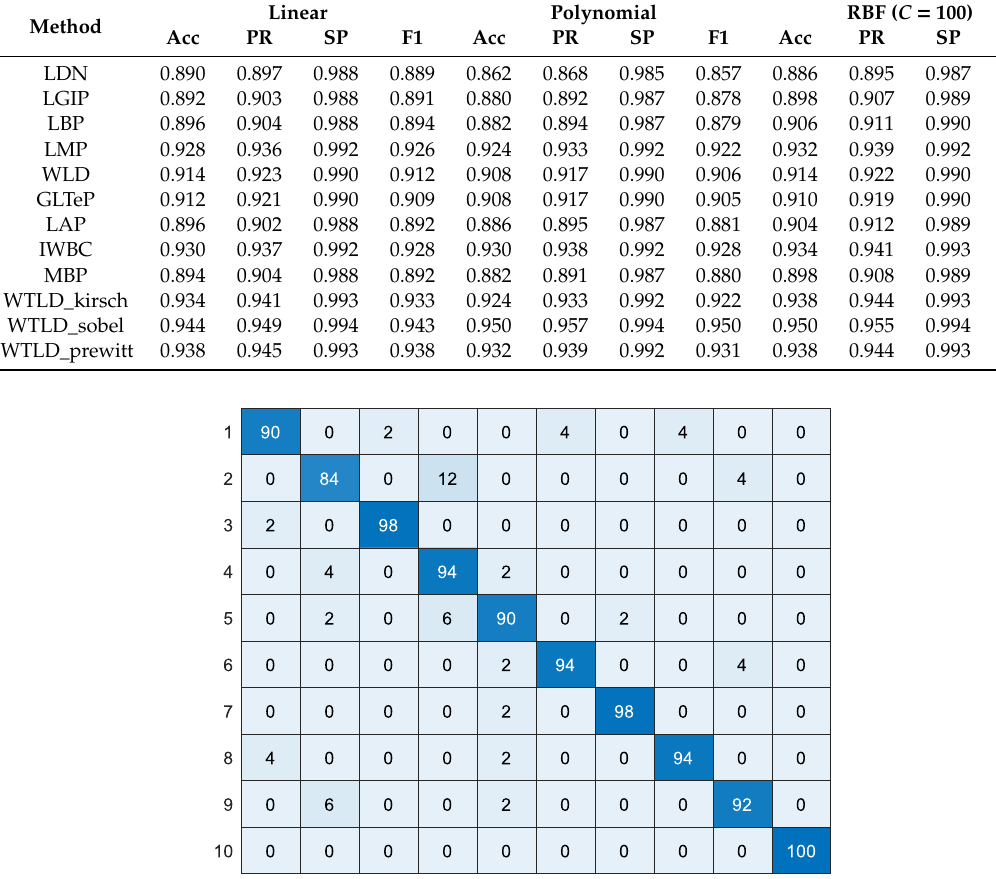
Table 4. Comparison of experimental results between WTLD and other local descriptors. Acc: accuracy, PR: precision, SP: specificity, F1: F1-score,LDN: local directional number pattern, LGIP: local gradient increasing pattern, LBP: local binary pattern, LMP: local monotonic pattern, WLD: Weber local descriptor, GLTeP: gradient local ternary pattern, LAP: local arc pattern, IWBC: improved Weber binary coding, MBP: median binary pattern, WTLD_kirsch: the results of WTLD with Kirsch masks, WTLD_sobel: the results of WTLD with Sobel masks, WTLD_prewitt: the results of WTLD with Prewitt masks.